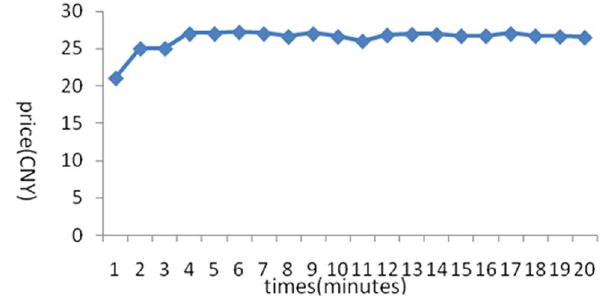
Figure 1. First Experiment of a Unilaterally Price-Rising Situation without Manipulation.